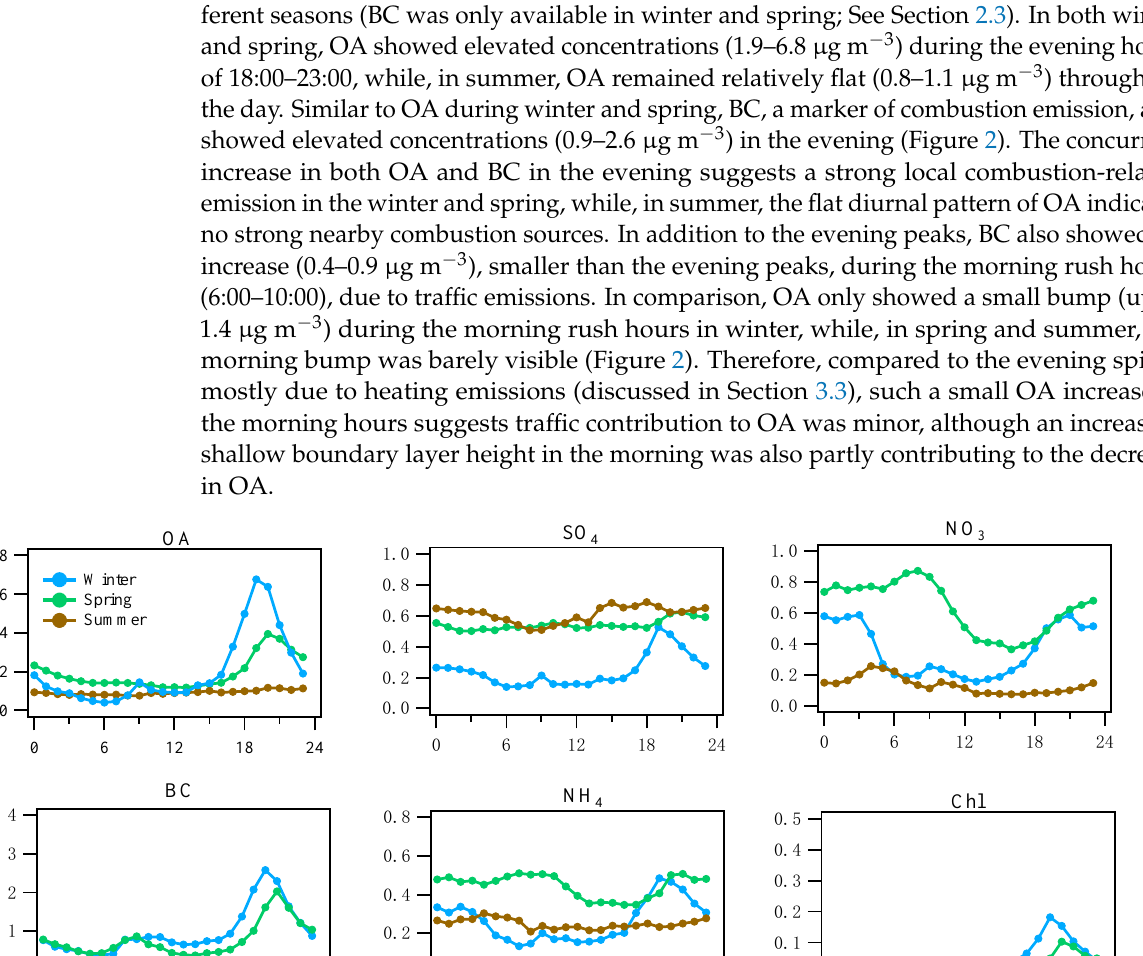
6 of 17 Figure 1. Time series of ( a ) wind speed (ws) and wind direction (wd); ( b ) relative humidity (RH) and Temperature (T); and ( c ) the major NR-PM 1 species, i.e., organics (OA), sulfate (SO 4 ), nitrate